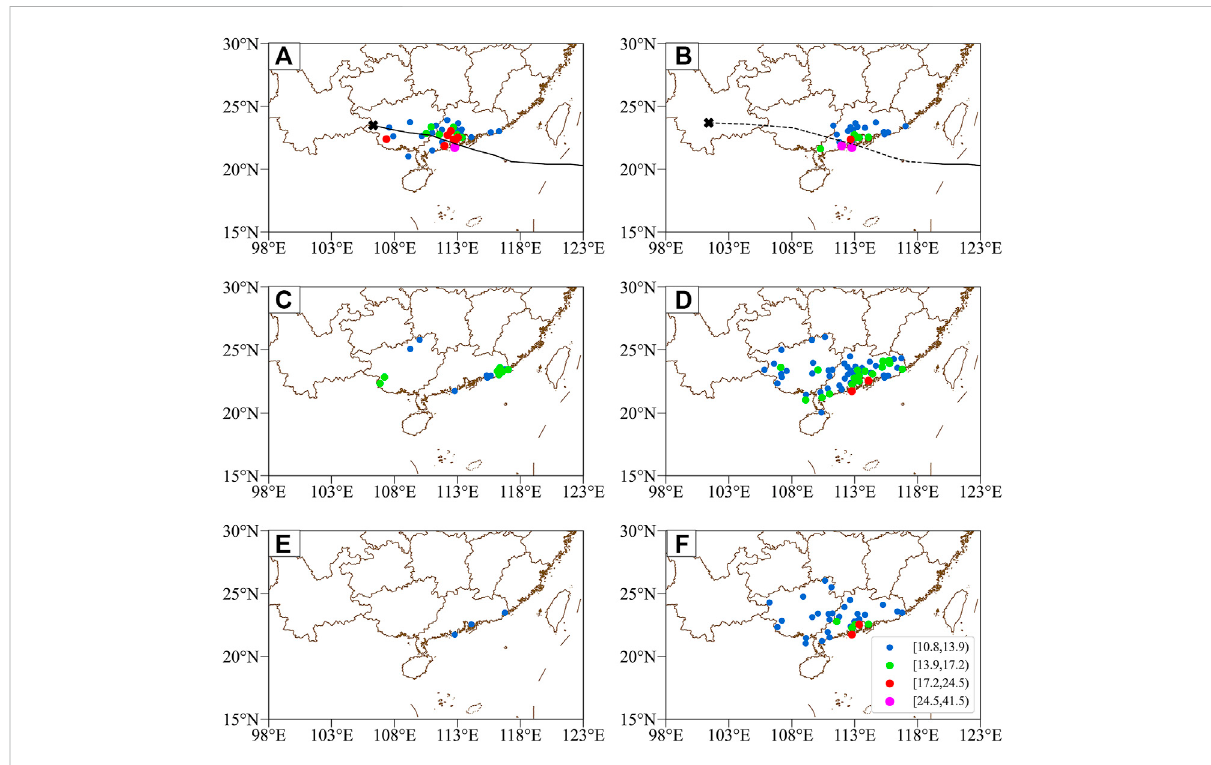
FIGURE 10 Spatial distributions of the potential maximum gale (m/s) associated with Hato according to (A) observations, (B) the DSAEF_LTG model, (C) CMA, (D) ECMWF, (E) JMA, and (F) NCEP. The observed and forecasted tracks are also plotted (black line and black dotted line, respectively). The marker “ × ” represents the end of the TC